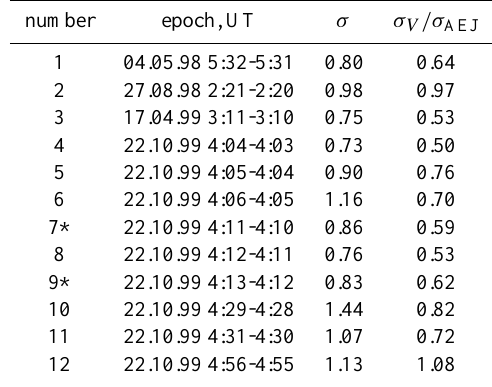
The normalised standard deviation σ and the ratio σ V /σ AEJ for the strongest dB/dt